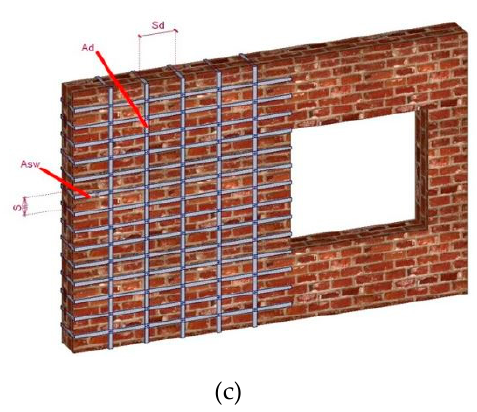
Figure 15. Strengthened structure ( a ) 4 additional walls; ( b ) FRP at the ground level; ( c ) FRP modeling in 3MURI [18].